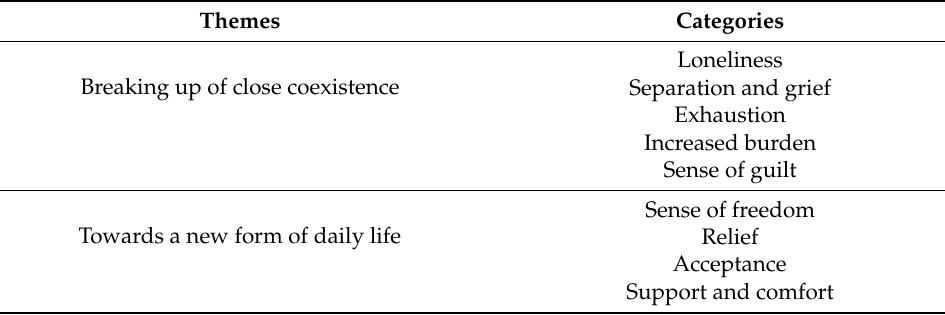
Table 3. Results of the analysis of themes and